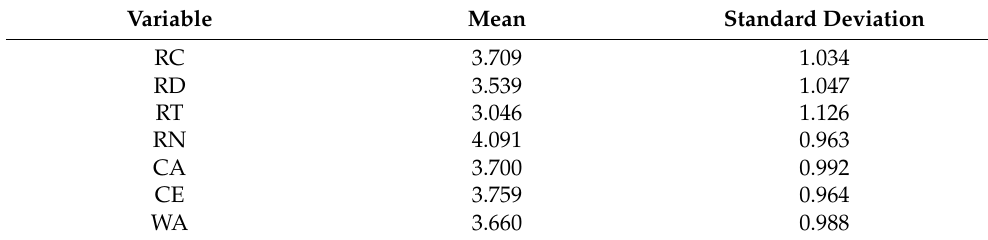
Table 2. Descriptive Statistics.